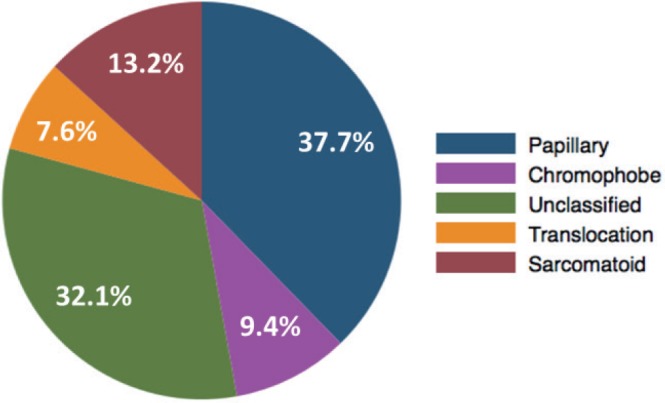
Pie chart of the distribution of histologic subtypes of nccRCC and sRCC in the study population.